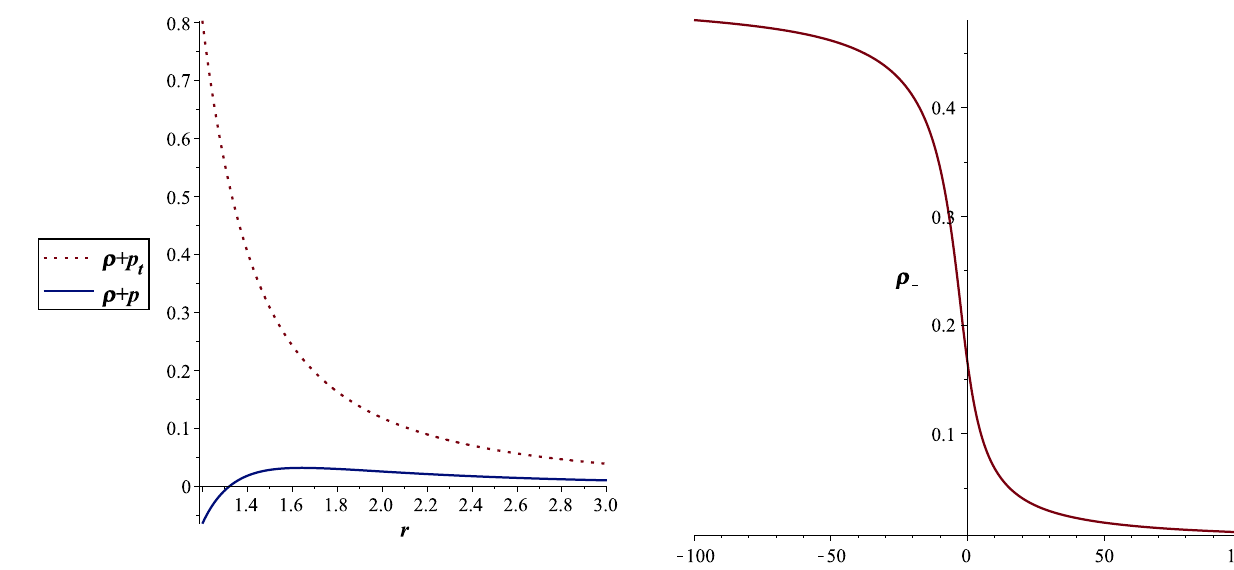
so ρ − is acceptable. 2